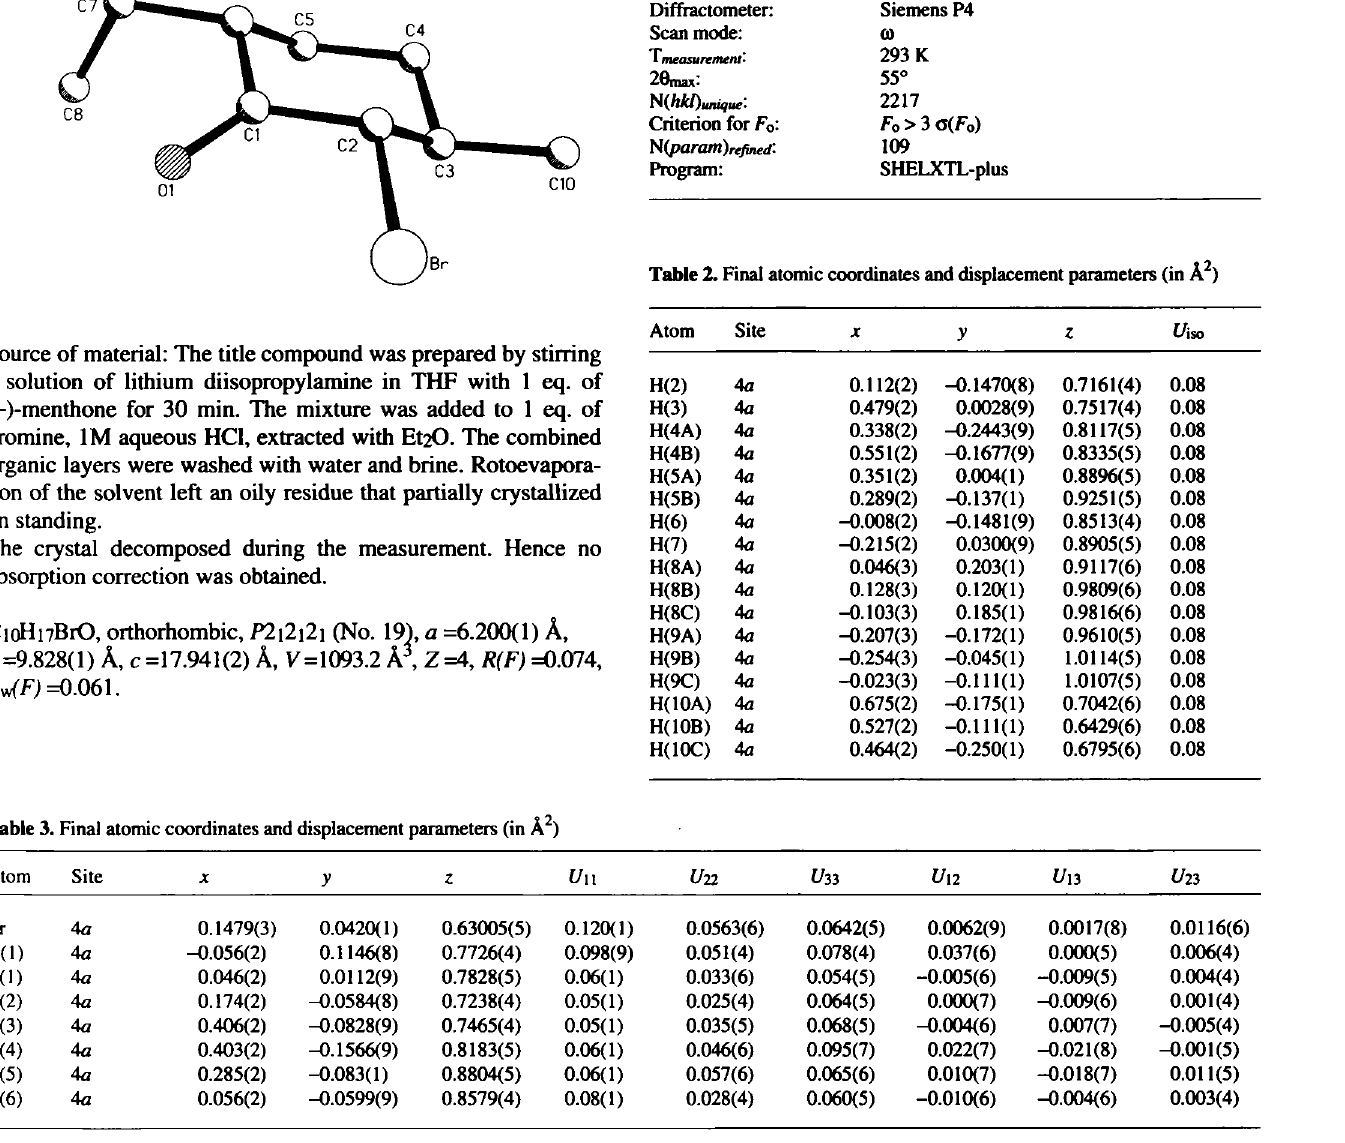
Table 1. Parameters used for the X-ray data collection